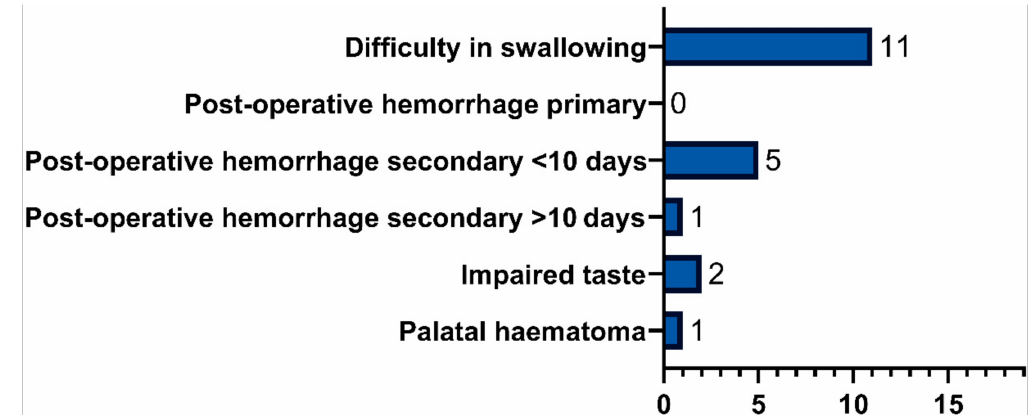
Figure 8. Post-operative symptom occurrence graph showing the number of patients with a post-operative